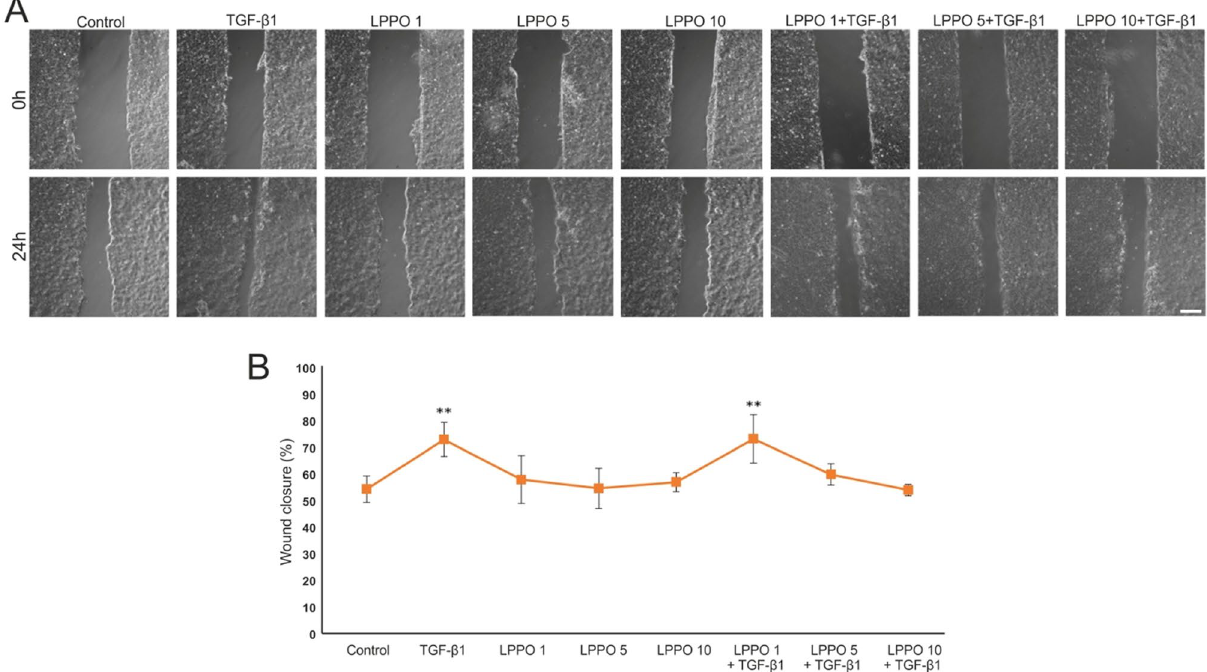
Figure 4. Migration (2D wound healing) assay of HaCaT keratinocytes with LPPO (1, 5 and 10 mg/mL) and/ or TGF-β1 (30 ng/mL); ( A ) representative figures of scratched confluent layer of HaCaT cells at time 0 and following 24 h; ( B ) Mean ± SD values from three independent experiments (** p < 0.01) (scale bar = 200 µm).